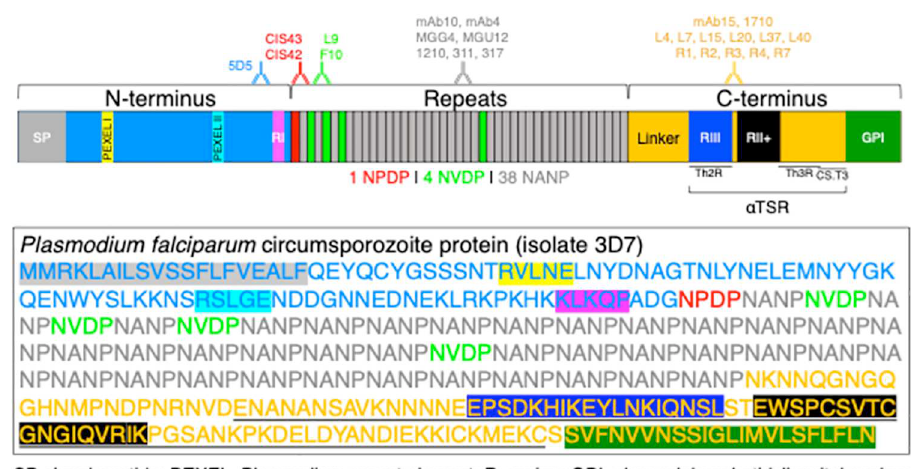
Fig 1. Schematic/sequence of PfCSP_3D7 and approximate epitopes bound by mAbs used in this study. Top: color-coded schematic illustrating the N-terminus (N-CSP), repeat region, and C-terminus (C-CSP) of PfCSP_3D7. N-CSP contains a signal peptide (SP), two Plasmodium export element (PEXEL) sites, and the conserved region I (RI). The repeat region is composed of three types of tetrapeptides (1 NPDP, 4 NVDP, and 38 NANP). C-CSP has a linker to the repeat region, an α -thrombospondin type-1 repeat ( α TSR) domain that contains two conserved motifs (region III and region II+, RIII and RII+) and several CD4+ helper T cell epitopes (Th2R, Th3R, CS.T3), and a glycosylphosphatidylinositol (GPI) anchor sequence. The binding sites of monoclonal antibodies used in this study are depicted. Bottom: sequence of PfCSP_3D7, color-coded to match the schematic. The sequence of the recombinantly expressed C-CSP construct used in this study is